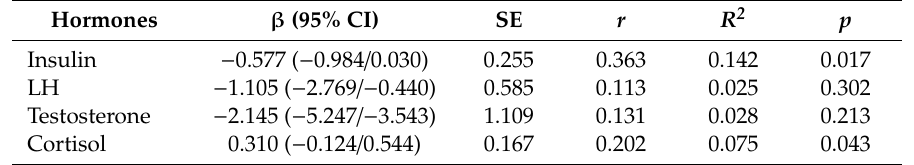
Table 5. Simple linear regression between the plasmatic concentration of hormones and total km trained. Hormones β (95%